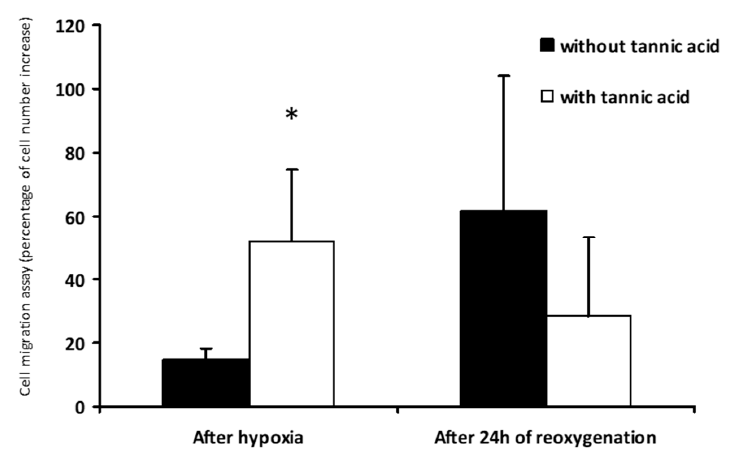
Figure 9. Tannic acid and gallic acid prevent oxidative stress induced by hypoxia – reoxygenation sequence. Reactive oxygen species production was determined by Cell ROX staining. ( A ) Representative pictures (40X) of staining in human aortic endothelial cells (HAEC) subjected to the hypoxia–reoxygenation sequence with or without tannic acid (7.3 µmol/L) or gallic acid (7.3 µmol/L); ( B ) quantitative evaluation of the staining. n = 4, values are mean ± SD, * p < 0,05.